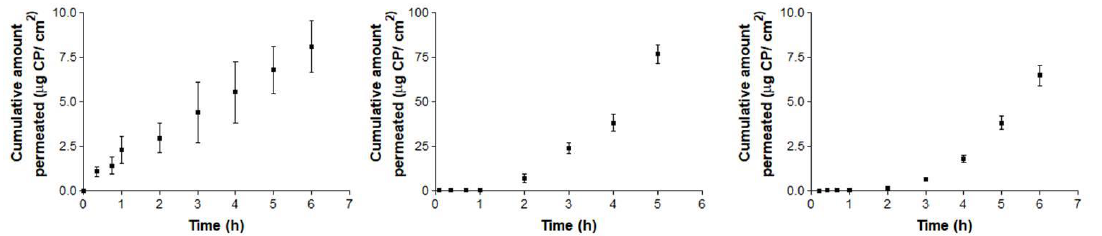
Figure 4. Ex vivo conjunctiva permeation (left), cornea (center) and scleral permeation (right) profiles of carprofen (CP) over 6 h, expressed by mean ± SD of six replicates (n = 6). Figure 5 represents permeation curves of CP through buccal, sublingual and vagina mucous